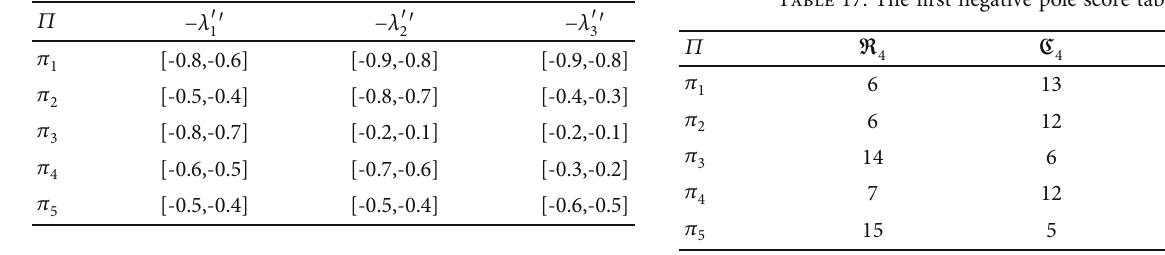
Table 13: The third negative pole membership intervals. ′′′ − λ Π − λ 1